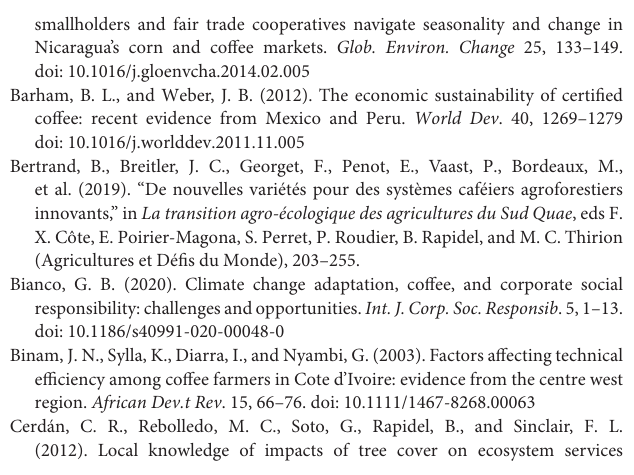
use; HA, Habitat for biodiversity. Supplementary Figure 1 | Species accumulation curves for three data sets and four typologies. Supplementary Figure 2 | Shannon index distribution for 140 plots in three data sets and four typologies. Supplementary Figure 3 | Species density distribution for 140 plots in three data sets and four typologies. Supplementary Figure 4 | Changes in canopy coverage and distribution for the original plot and three different scenarios for a Musa-dominated plot (MD). Four canopy components are graphed—banana (blue), Inga (green), timber trees (red), and other trees (black). Supplementary Figure 5 | Changes in canopy coverage and distribution for the original plot and three different scenarios for an Inga -dominated plot (ID). Four canopy components are graphed—banana (blue), Inga (green), timber trees (red), and other trees (black). Supplementary Figure 6 | Changes in canopy coverage and distribution for the original plot and three different scenarios for a plot dominated by other trees (TD). Four canopy components are graphed—banana (blue), Inga (green), timber trees (red), and other trees